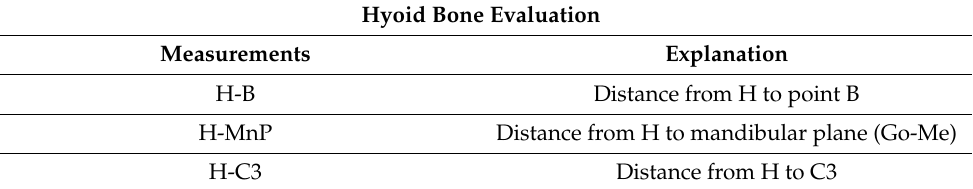
Table 2. Criteria for hyoid bone measurements.